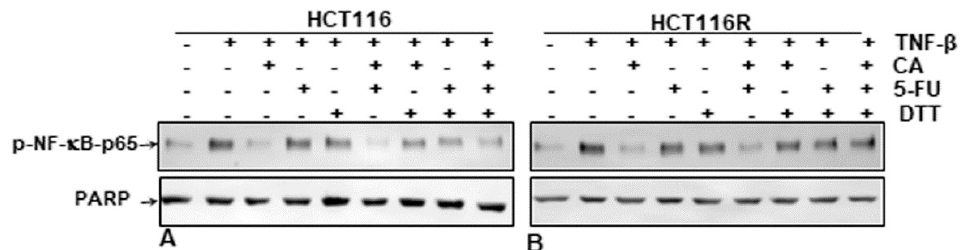
Figure 7. E ff ect of dithiothreitol (DTT) on the suppressive impact of Calebin A and / or 5-FU in TNF- β -promoted p65-NF- κ B interaction to DNA. Extracted nuclei of untreated and Table 116. ( A ) and HCT116R ( B ) cells were co-treated with Calebin A and / or 5-FU in the absence or presence of DTT and then immunoblotted for p65-NF- κ B activation. The results are demonstrated from at least three independent assays and the housekeeping protein PARP served as an internal loading control. Densitometric evaluation was performed for p65-NF- κ B. * p < 0.05, ** p < 0.01.